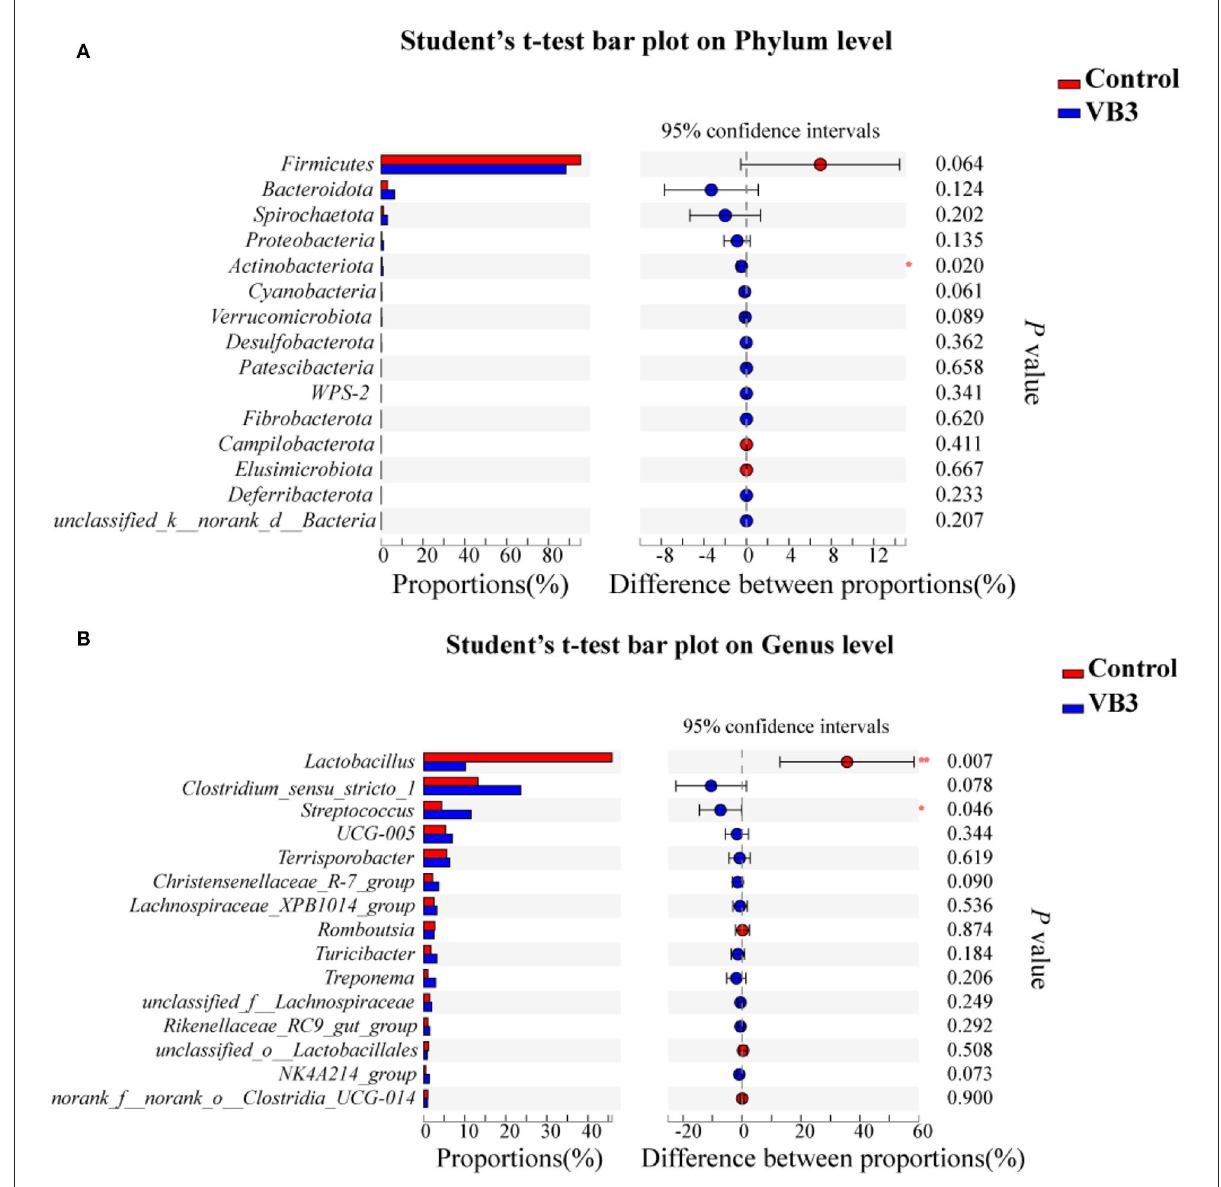
FIGURE2 Relative abundance of bacteria community in the experimental group (VB3) and control group (Control) at phylum (A) and genus (B) levels. * P < 0.05; ** P <